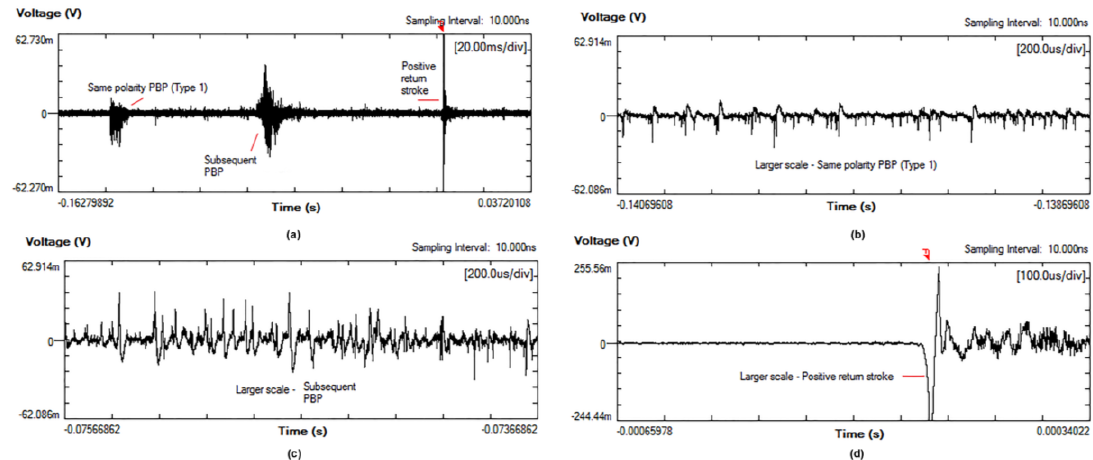
Figure 3 . ( a ) Type 1 PBP—Same polarity PBP; ( b ) Zoom in of PBP train having the same polarity pulses as the positive RS; ( c ) Zoom in of the subsequent PBP trains; ( d ) Zoom in of positive RS.